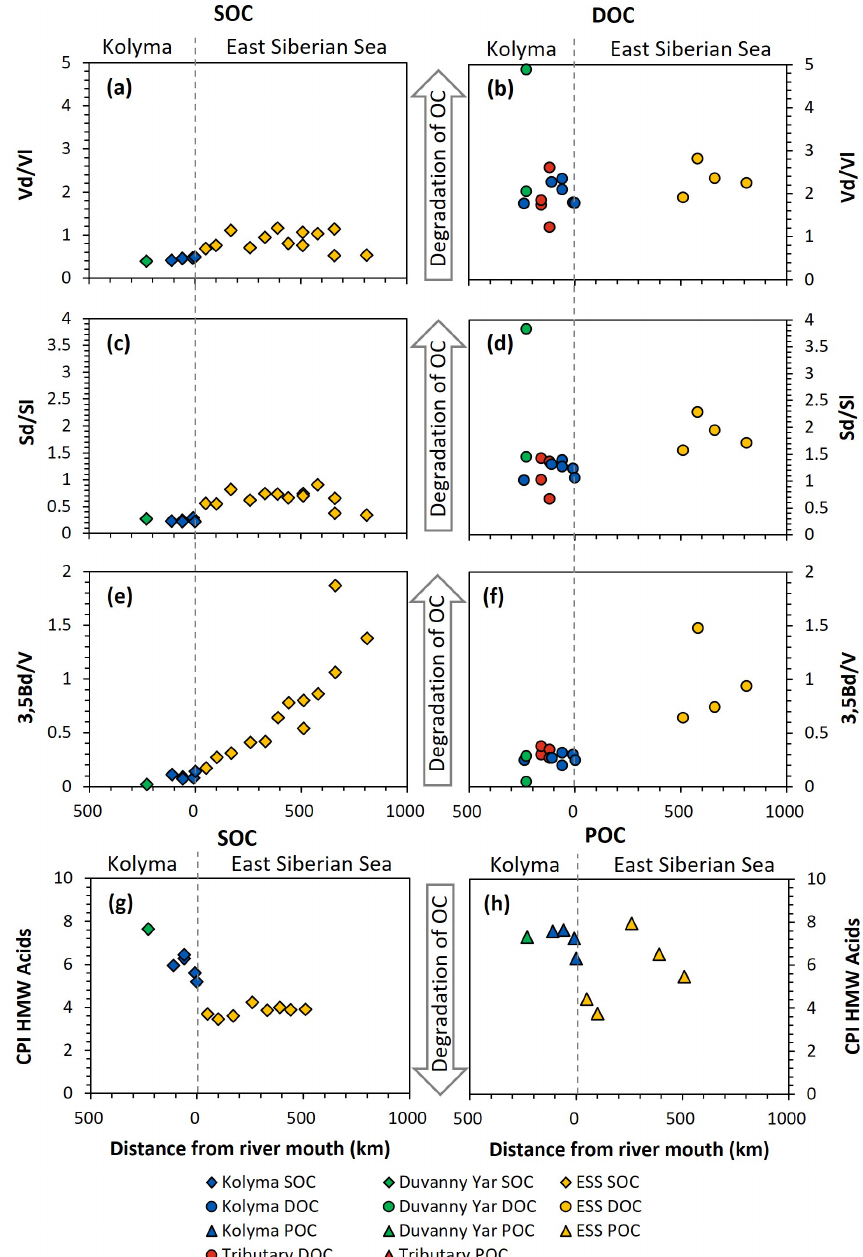
Figure 7. Biomarker degradation proxies of sediment organic carbon (SOC; diamonds), dissolved organic carbon (DOC; circles) and par- ticulate organic carbon (POC; triangles) from the Kolyma River (blue), Duvanny Yar (green), East Siberian Sea (ESS; yellow) and a couple smaller tributaries of the Kolyma (red) over transect distance. For visual aid the arrows in the middle point towards more degraded values. (a) Acid / aldehyde ratio of Vanillyl phenols (Vd / Vl) of SOC, and (b) of DOC. (c) Acid to aldehyde ratio of Syringyl phenols (Sd / Sl) of SOC, and (d) of DOC. (e) 3,5Bd / V ratio of SOC, and (f) DOC. (g) the carbon preference index of HMW n -alkanoic acids (C24–C30) of SOC, and (h) of